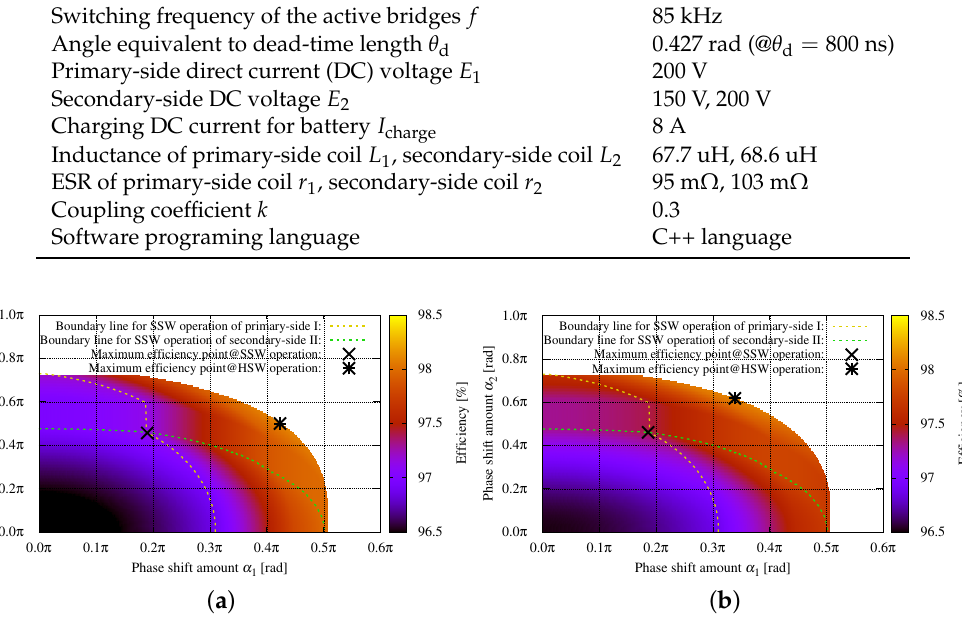
Figure 5. Efficiency map of the resonant circuit with each operation mode. ( a ) At I charge = 8 A, E 1 = 200 V and E 2 = 150 V; ( b ) At I charge = 8 A, E 1 = 200 V and E 2 = 200